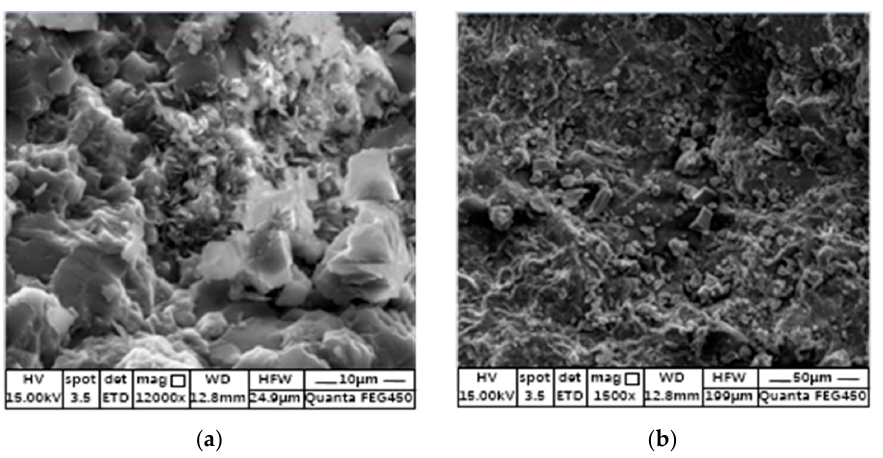
Figure 21. Internal structure of rock samples. ( a ) Internal structure of sandy conglomerate; ( b ) Internal structure of purplish red mudstone.